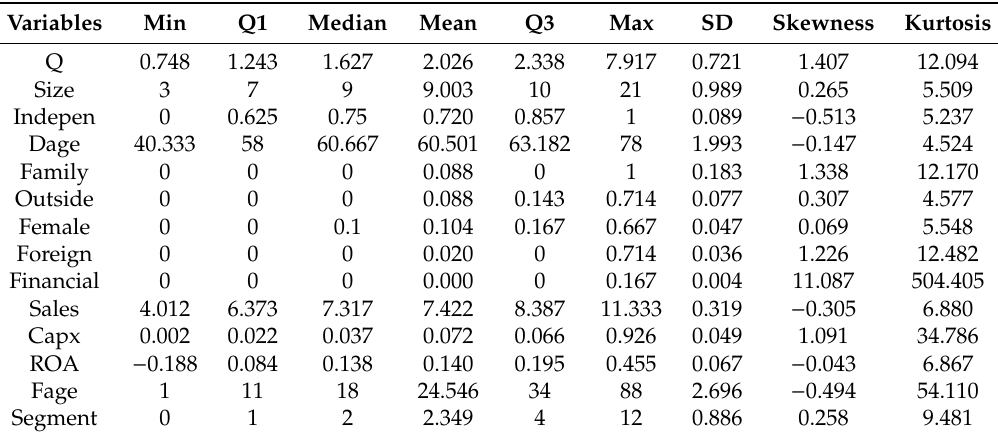
Table 1. Summary